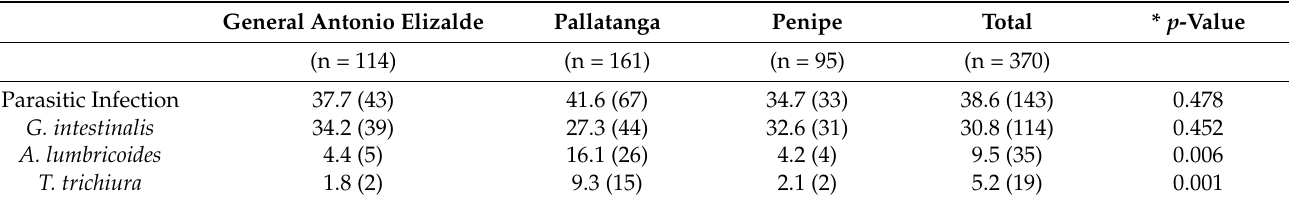
Table 3. Frequencies (%) of the studied population according to the presence of total parasitic infection and infection by G. intestinalis , A. lumbricoides and T. trichiura stratified by municipality. General Antonio Elizalde Pallatanga Penipe